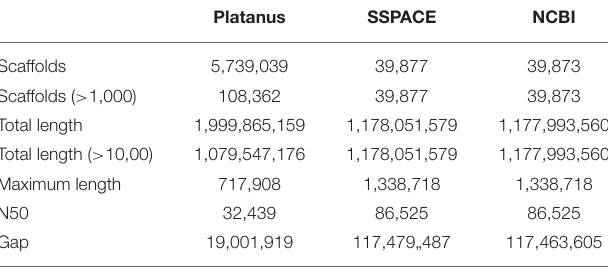
TABLE 1 | Statistics of the genome